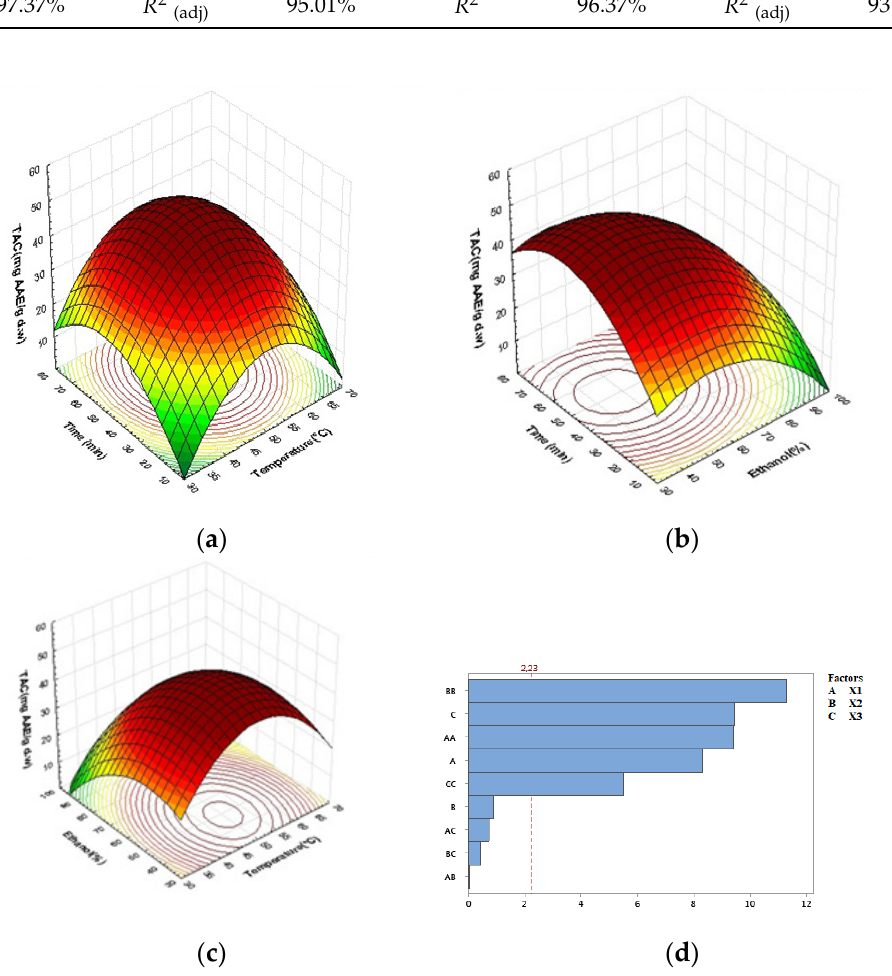
Figure 4. Response surface plots indicating combined effects of UAE variables on TAC: ( a ) time and temperature, ( b ) time and ethanol concentration, ( c ) ethanol concentration and temperature, ( d ) Pareto chart ( α = 0.05). TAC = −165.4 + 1.345X + 5.960X + 1.328X − 0.01261X (cid:2869)(cid:2870) − 0.06058X (cid:2870)(cid:2870) − 0.01318X (cid:2871)(cid:2870) + 0.00014X (cid:2869) (cid:2870) (cid:2871) − 0.00175X X + 0.00218X X (cid:2869) (cid:2871) (cid:2870) (cid:2871) On the other hand, the linear influence of extraction temperature and the in- teraction terms of all variables were insignificant ( p > 0.05).